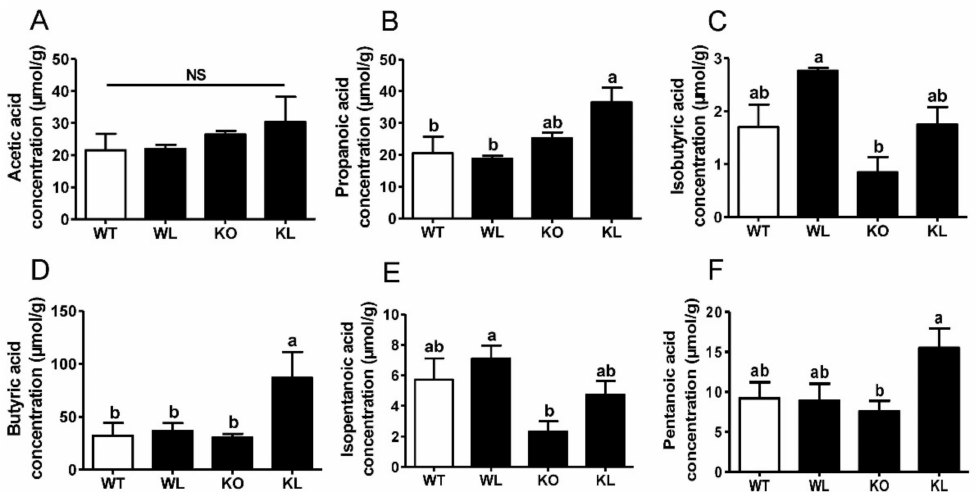
Figure 9. LWE increased the level of SCFAs in Lepr − / − rats. The concentration of ( A ) acetic acid, ( B ) propanoic acid, ( C ) isobutyric acid, ( D ) butyric acid, ( E ) isopentanoic acid and ( F ) pentanoic acid were measured. Values are means ± SEM (n = 4–5). Columns with different letters are significantly different ( p <